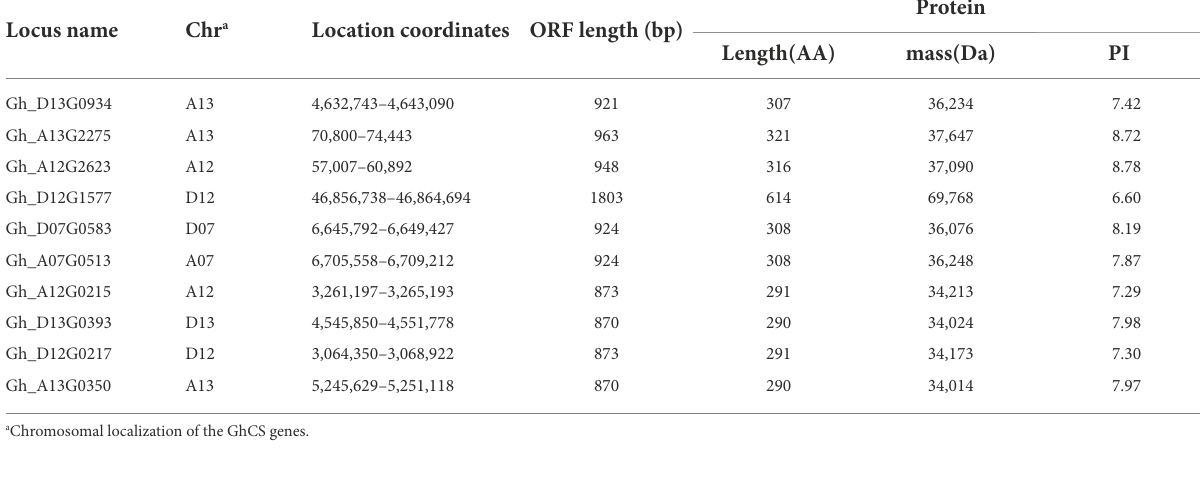
TABLE 1 Ten identified ceramide synthase genes ( GhCSs ) in upland cotton genome.